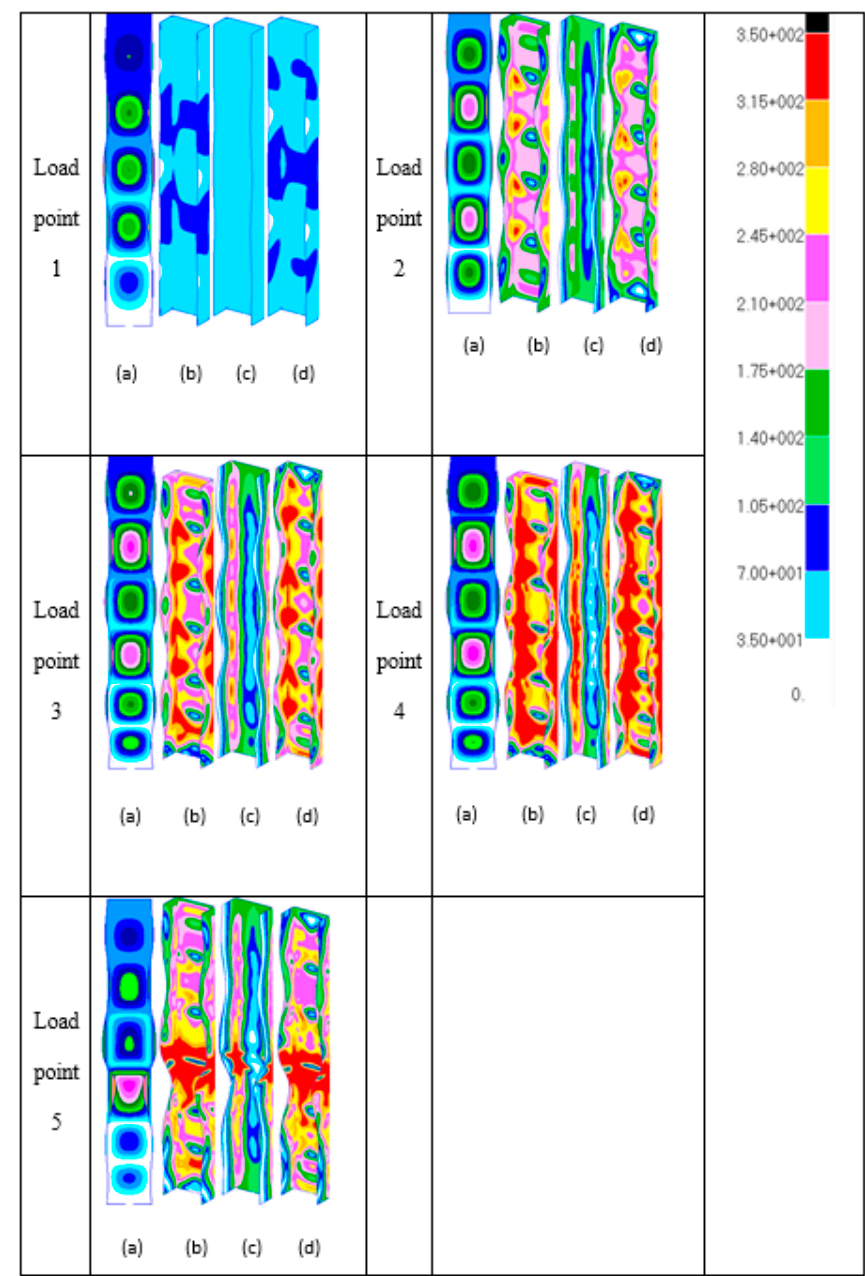
Figure 9. Deformation images ( a ) and growth of von Mises stresses with load (( b ) outer surface 1; ( c ) middle surface; and ( d ) outer surface 2) of Figure 8 (full-model).